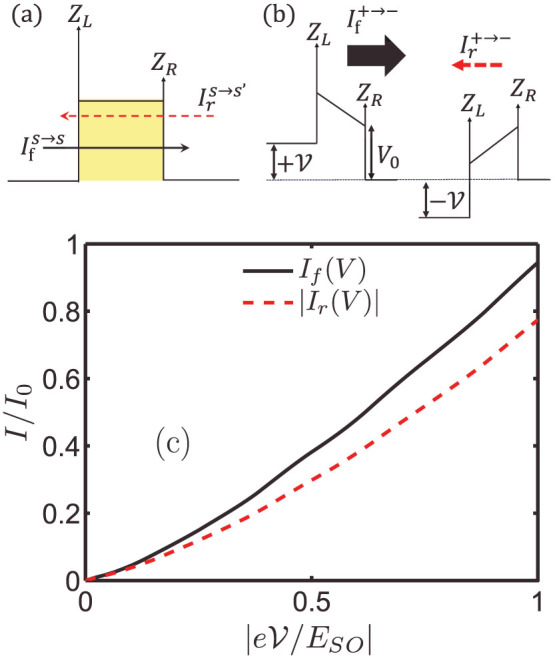
Scattering quantum ratchet in R2DEG.(a) Schematic drawing of the right-going current  and  ; (b)  and  becomes unequal in the presence of asymmetrical ZL and ZR; (c) the current-voltage characteristic of the R2DEG tunnel junction. (EF = 0.5ESO, d = 20 nm, V0 = ESO, ZL = 1.5 and ZR = 0.5)